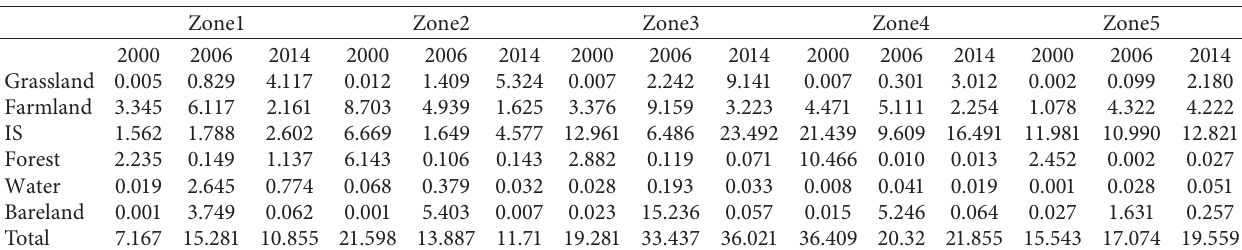
Figure 6: The spatial pattern of LST zones from 2000 to 2014. (a) 2000. (b) 2006. (c) 2014. Table 3: The proportion of LULC types (%) of different LST zones from 2000 to